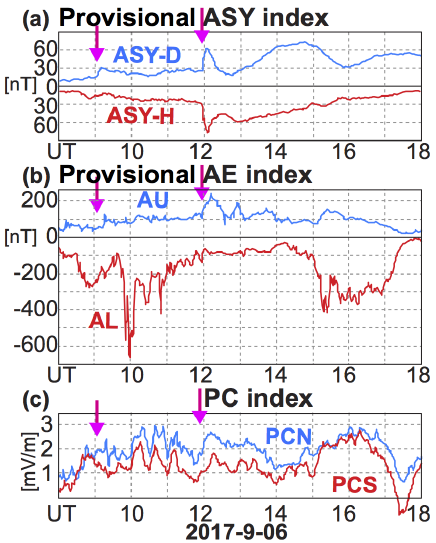
Figure 2. Geomagnetic indices that represent asymmetric distur- bances at midlatitude (ASY), auroral electrojet (AE), and polar cap electric field